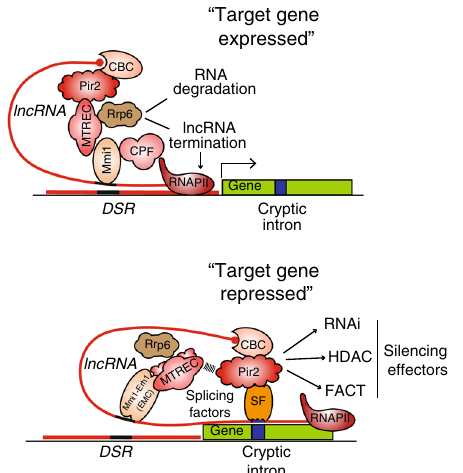
Fig. 6 Pir2 and splicing machinery engage cryptic introns within lncRNA to promote repression. Model depicting the switch to co-transcriptional repression through the cryptic intron. For gene expression, lncRNA is terminated and degraded upstream of target loci by CPF, MTREC, and Rrp6, which are recruited by Mmi1 bound to DSR elements. Upon changes in growth conditions, the lncRNA extends into the neighboring region containing the cryptic intron, providing a scaffold for co-transcriptional recruitment of Pir2-splicing machinery, which in turn recruits silencing effectors including RNAi, HDAC, and FACT to promote gene repression. Mmi1 acts as part of the EMC to engage MTREC and other factors that together with CBC stabilize Pir2 association with lncRNAs and effector